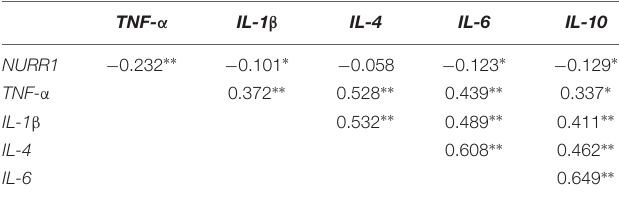
TABLE 3 | Spearman correlation coefficient (R) between the expression levels of NURR1 , TNF- α , IL-1 β , IL-4 , IL-6, and IL-10 in the PBMCs of PD. TNF- α IL-1 β IL-4 IL-6